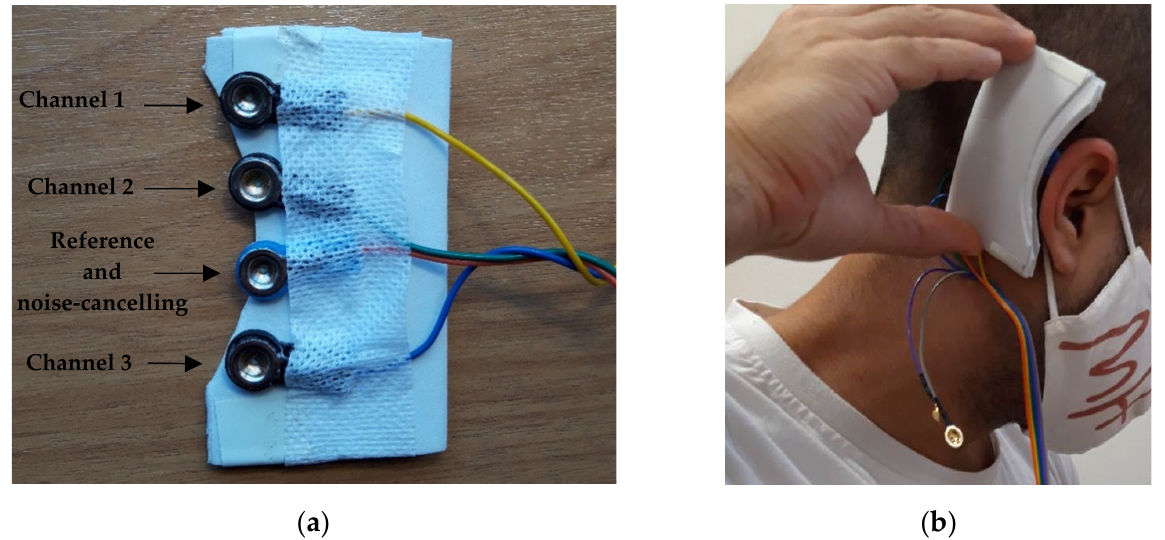
Figure 2. ( a ) Flexible gold cup electrode array; ( b ) Placement of the flexible gold cup electrode array behind the ear. The electrode array is held in the right place by two elastic fabric strips.